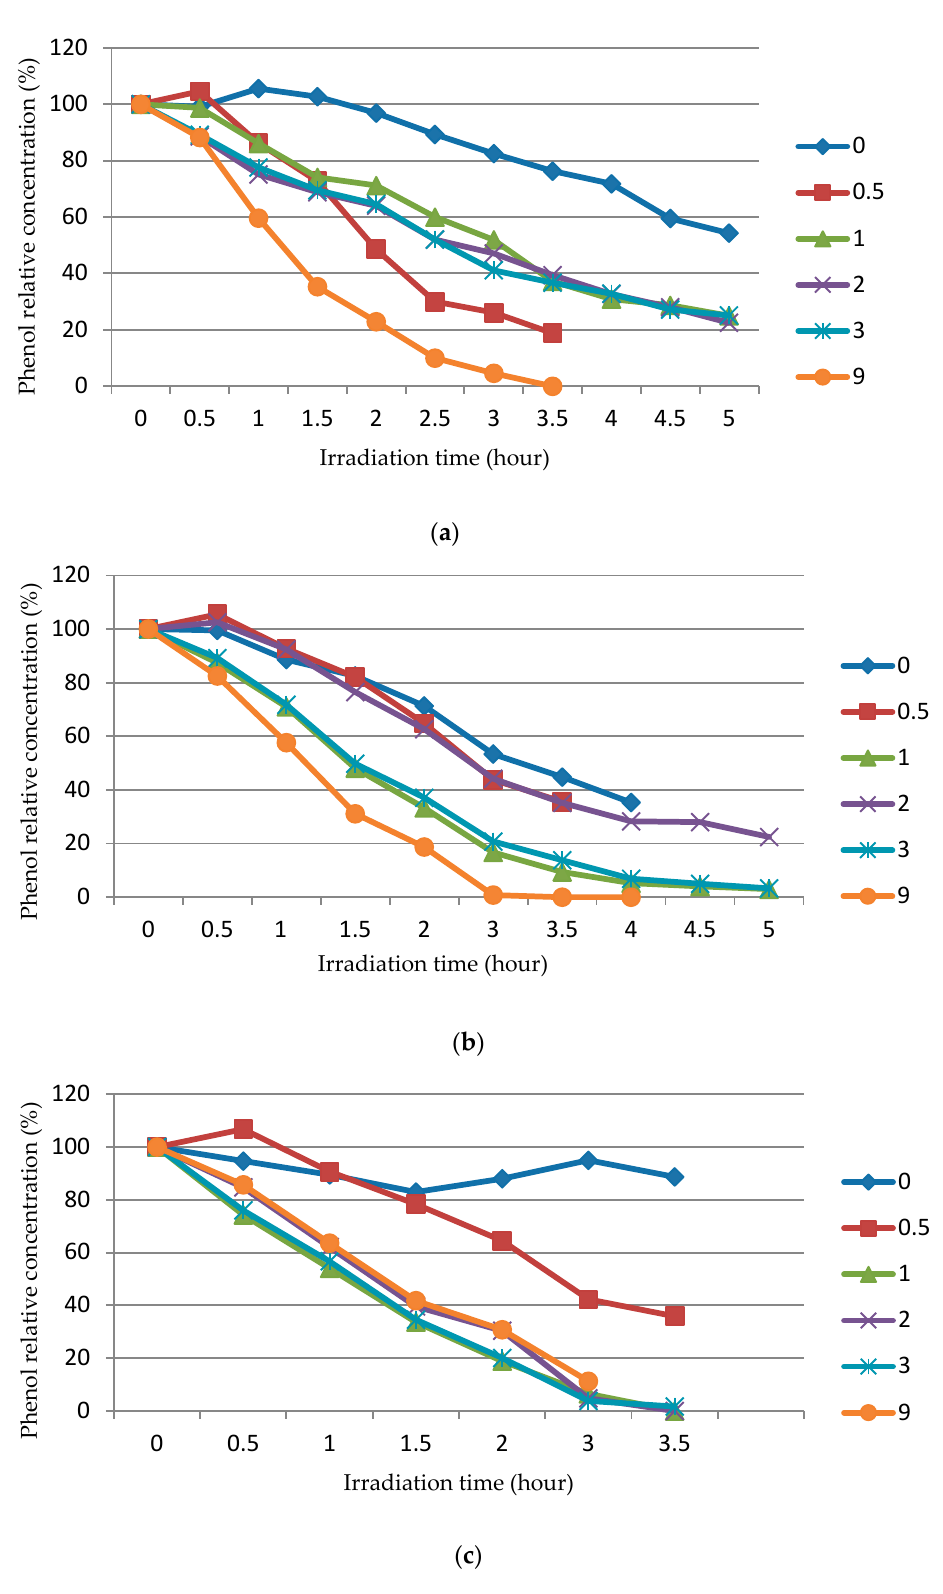
Figure 9. The dependence of the relative concentration (%) of phenol (C/C 0 ) in an aqueous solution on the ultraviolet irradiation at different φ after different durations of ZnO calcination (numbers at the line designate hours): ( a ) φ = 0.25; ( b ) φ = 1; ( c ) φ = 2.